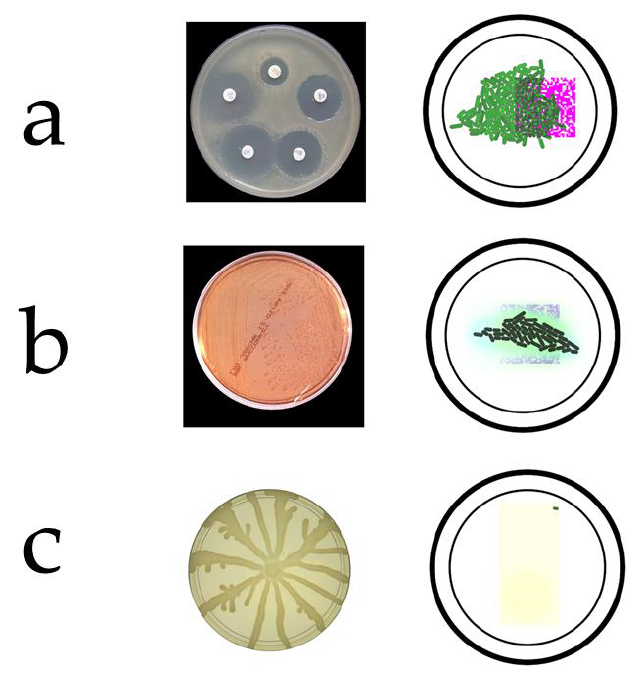
Figure 3. Screening procedures developed in Gro language. ( a ) Antibiotic resistance, ( left ) detail of an antibiogram and ( right ) its simulation. ( b ) Lac operon, ( left ) A MacConkey agar plate with a bacterial culture of microbes fermenting lactose and ( right ) its simulation. ( c ) Chemotaxis, ( left ) Pseudomonas aeruginosa swarming motility and ( right ) its simulation.